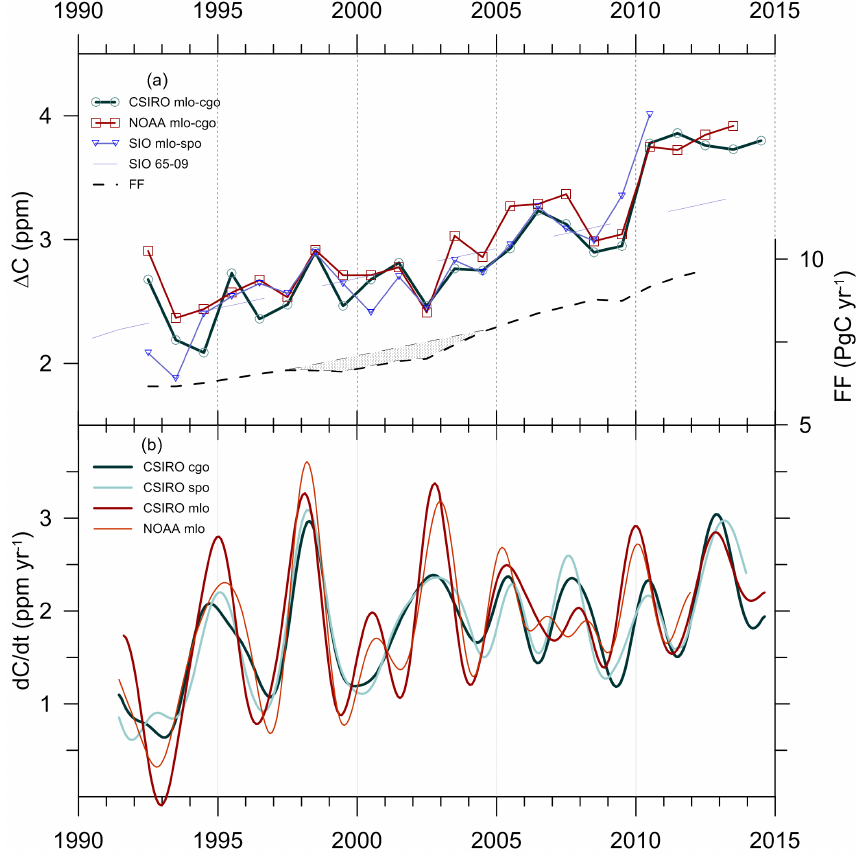
Figure 1. North–south differences and growth rates in CO 2 since 1990. Panel (a) shows, on the left axis, annual average (January–December) (cid:49) C (ppm) from three programs – CSIRO, NOAA (mlo–cgo), and SIO (mlo–spo) – plotted mid-year. On the right axis are reported anthro- pogenic emissions (dashed line), with the correction suggested by Francey et al. (2013) (shaded), scaled so that the overall slope is similar to that from the long-term mlo–spo SIO record. Panel (b) : CSIRO (mlo, cgo, spo) and NOAA (mlo) growth rates, dC/d t , plotted mid- month. See the “Methods” section for